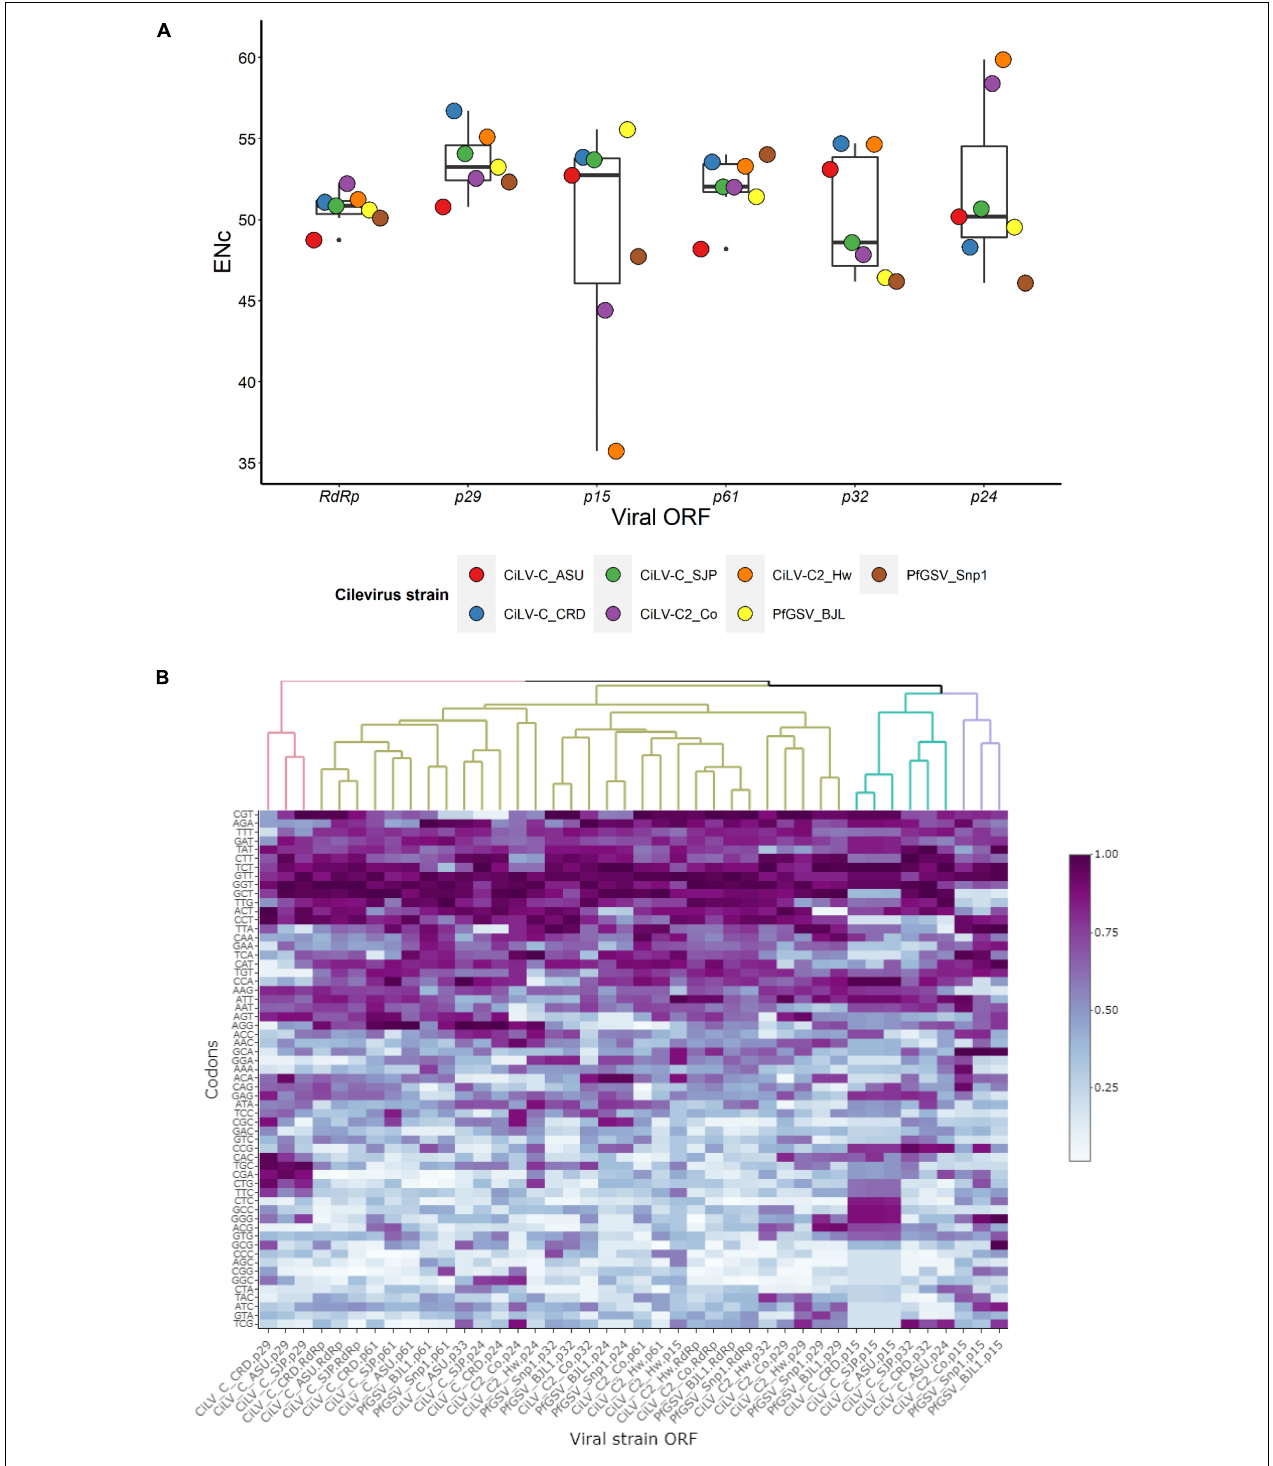
FIGURE 4 | Codon usage bias of cilevirus ORFs. (A) Boxplot of Effective Number of codons (ENc). ENc values were calculated using COUSIN webserver (http://cousin.ird.fr/index.php) and plotted in Rstudio (Rstudio_team, 2021). (B) RSCU profiles across ORF of seven different isolates of three species of cileviruses. RSCU values were obtained using the CAIcal webserver (https://ppuigbo.me/programs/CAIcal/). The heat map was drawn in Rstudio using the “heatmapply” function (Galili et al., 2018). RSCU values were transformed using the “percentize” method and dist_method = “Euclidean” and hclust_method = “complete” were selected. Darker purple represents higher RSCU